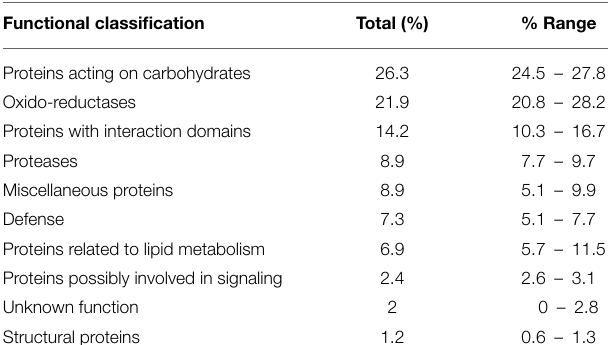
TABLE 2 | Functional classification of the predicted cell wall proteins (CWPs) detected by LC-MS/MS analyses and based on the non-redundant Mt4.0v1